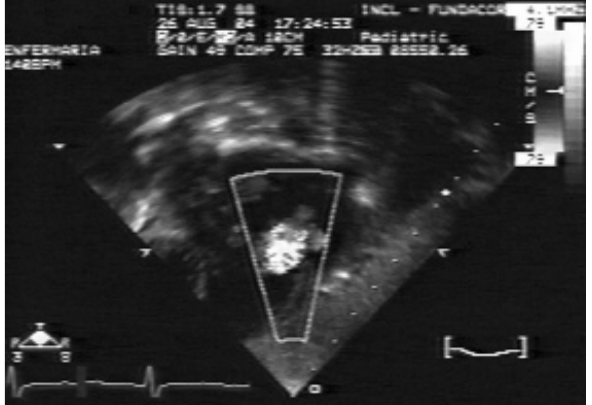
Fig. 2 - Eco-doppler mostra regurgitação mitral com jato de colisão sobre fragmento de pericárdio